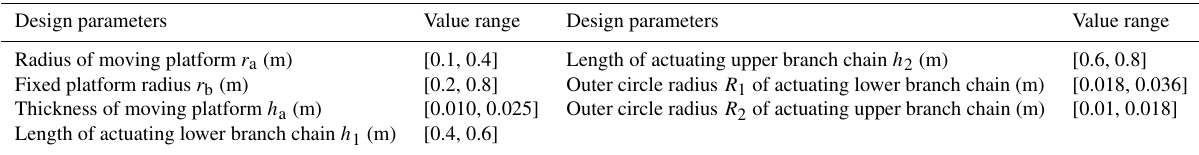
Table 1. Experiment design objective function value.